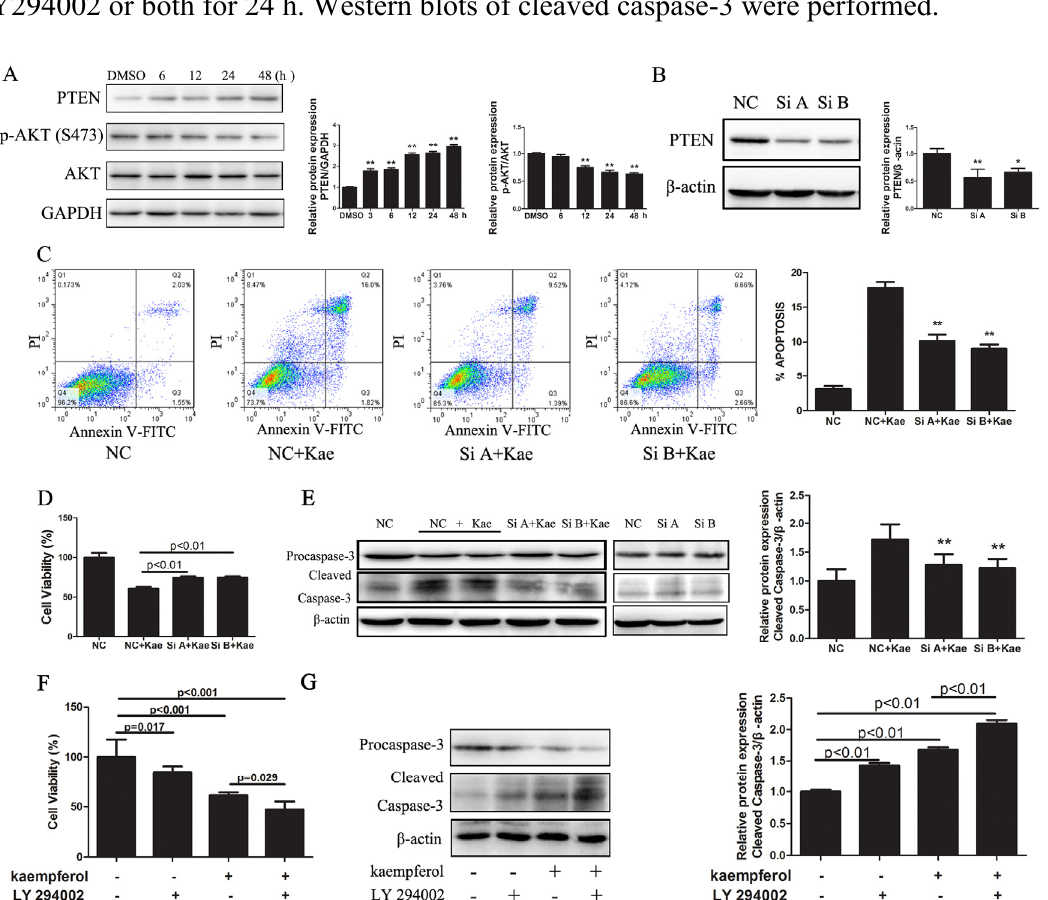
Figure 4. Kae-induced apoptosis in EJ cells involves PTEN. ( A ) Kae upregulates PTEN expression in a time-dependent manner. EJ cells were treated with 40 μ M Kae for the indicated times. Levels of PTEN and Akt were detected by Western blotting. Data are expressed as the mean ± SD from three independent experiments ( ** p < 0.01 vs . DMSO-only group); ( B ) siRNA (Si A and Si B) inhibits PTEN expression; control siRNA was used as the negative control (NC) ( * p < 0.05, ** p < 0.01 vs . NC); ( C ) PTEN siRNA inhibits Kae-induced apoptosis. PTEN siRNA-transfected EJ cells treated with 40 μ M Kae cells treated with 40 μ M Kae. Data represent the mean ± SD of three independent experiments ( ** p < 0.01 vs . NC + Kae group); ( D ) PTEN siRNA attenuates the treated with 40 μ M Kae for 24 h; cell viability was determined by the CCK-8 assay. Data Kae-induced cleavage of caspase-3. Western blots of cleaved caspase-3 in PTEN siRNA- or NC siRNA-transfected cells treated with 40 μ M Kae for 24 h ( ** p < 0.01 vs . NC + Kae group); ( F ) LY294002 enhances Kae-inhibition of EJ cell growth. EJ cells were treated with 40 μ M Kae, 20 μ M LY294002 or both for 24 h. Cell viability was determined by the CCK-8 assay. Data shown are the mean ± SD of three independent experiments; ( G ) LY294002 enhances Kae-induced cleavage of caspase-3. EJ cells were treated with 40 μ M Kae, 20 μ M LY294002 or both for 24 h. Western blots of cleaved caspase-3 were